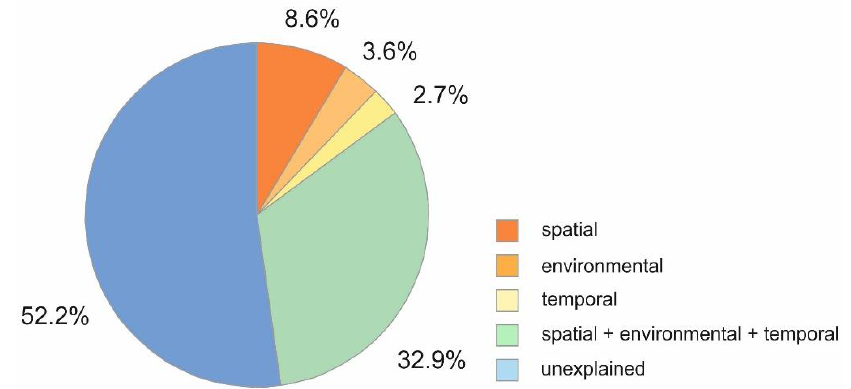
Prop. R 2 adj Parameter Prop. (cumul.) (cumul.) Table 6. DistLM (distance-based linear model) results showing the relationship between environmental (food availability and sediment porosity), spatial (water depth and sediment depth), and temporal (years) parameters on variation in meiofauna community structure (Bray-Curtis similarity of square-root transformed abundance of meiofauna taxa). Marginal test: explains the proportion of each parameter alone, ignoring all other parameters; sequential test: indicates the increase in the proportion of variation explained with each parameter added in a combined model Water depth ** - (all specified selection procedure with adjusted R 2 selection criterion). Prop.: proportion of total variation explained; prop. (cumul.): running cumulative proportion total; R 2adj : adjusted R 2 ; * p < 0.05, ** p < 0.01. Prop. R 2adj Prop. (cumul.)